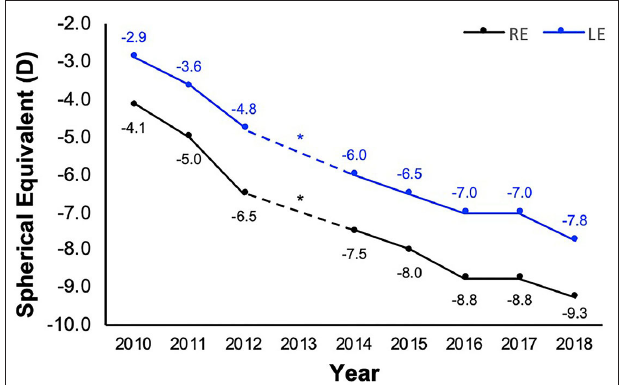
FIGURE 1 | Refraction of a participant with rapid myopia progression from 20 (year 2010) to 28 years old (year 2018). Refraction (spherical equivalent) history obtained from participant’s optometrist *apart from 2013 when the participant did not visit the optometrist. The participant reported their occupation during the 8-year period to be computer-intensive (at or close to 100%), with the exception of the year 2013 and mid-2016 to 2017, when most of their time was spent on outdoor academic field work or traveling. While no refraction data was available at 2013 (*), from 2016 to 2017, no myopia progression was